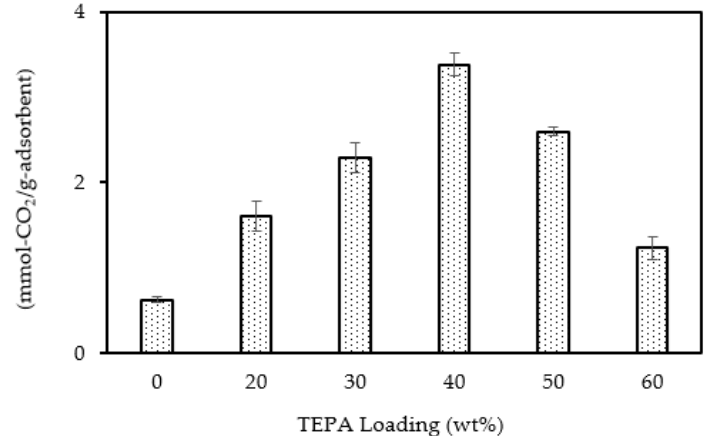
Figure 7. Average CO 2 adsorption capacity of unfunctionalized MSU-2 and MSU-2 functionalized with TEPA loadings of 20 wt%, 30 wt%, 40 wt%, 50 wt% and 60 wt% at 40 °C, at 1 bar of pressure and 50% CO 2 /50% CH 4 gas mixture.